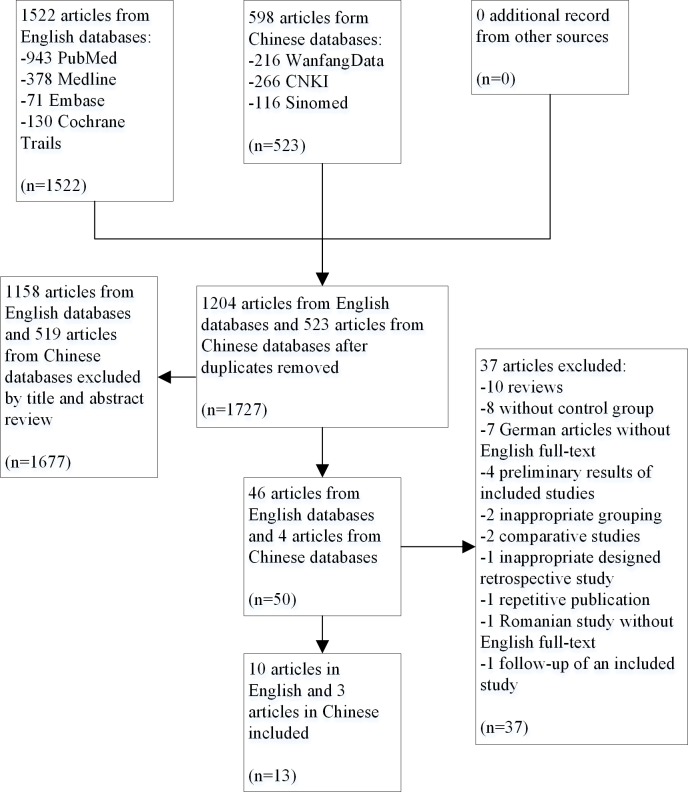
Flow diagram of study selection.